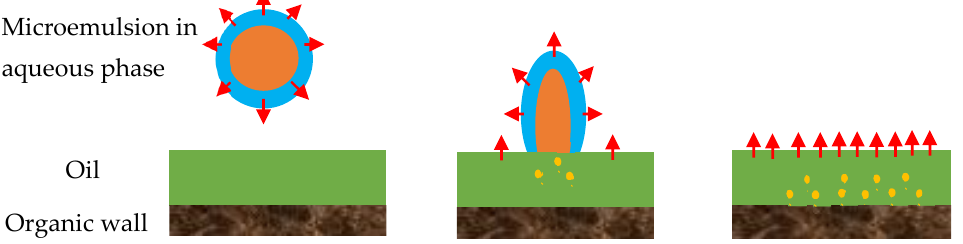
Figure 3. Adsorption of a microemulsion droplet to the oil/water interface by the organic wall. The droplet arrives at the oil/water interface and breaks down; after that, solvent molecules penetrate further into the oil phase and approach to the pore wall. Reproduced with permission from [18].